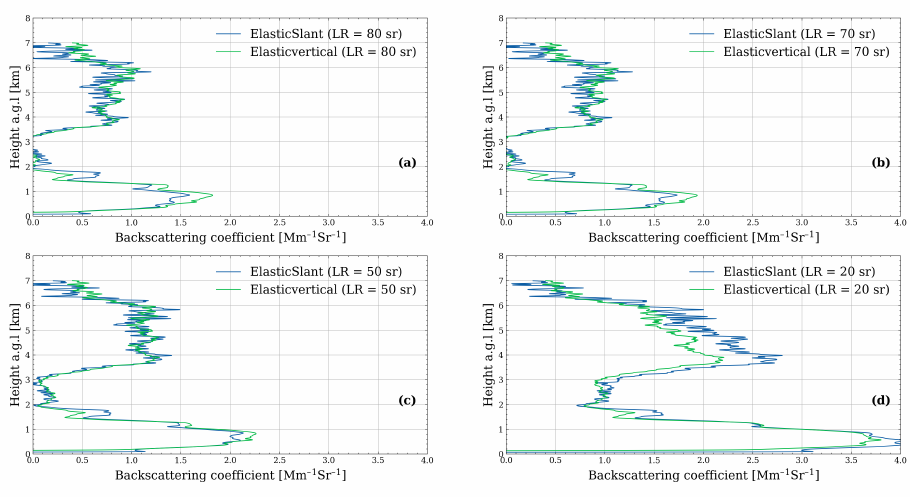
Figure 3. Vertical and slant backscatter coefficients from LiDAR measurements from 19:21 to 22:54 (UTC) on 8 April 2018 for LiDAR ratios ranging from 20 sr to 80